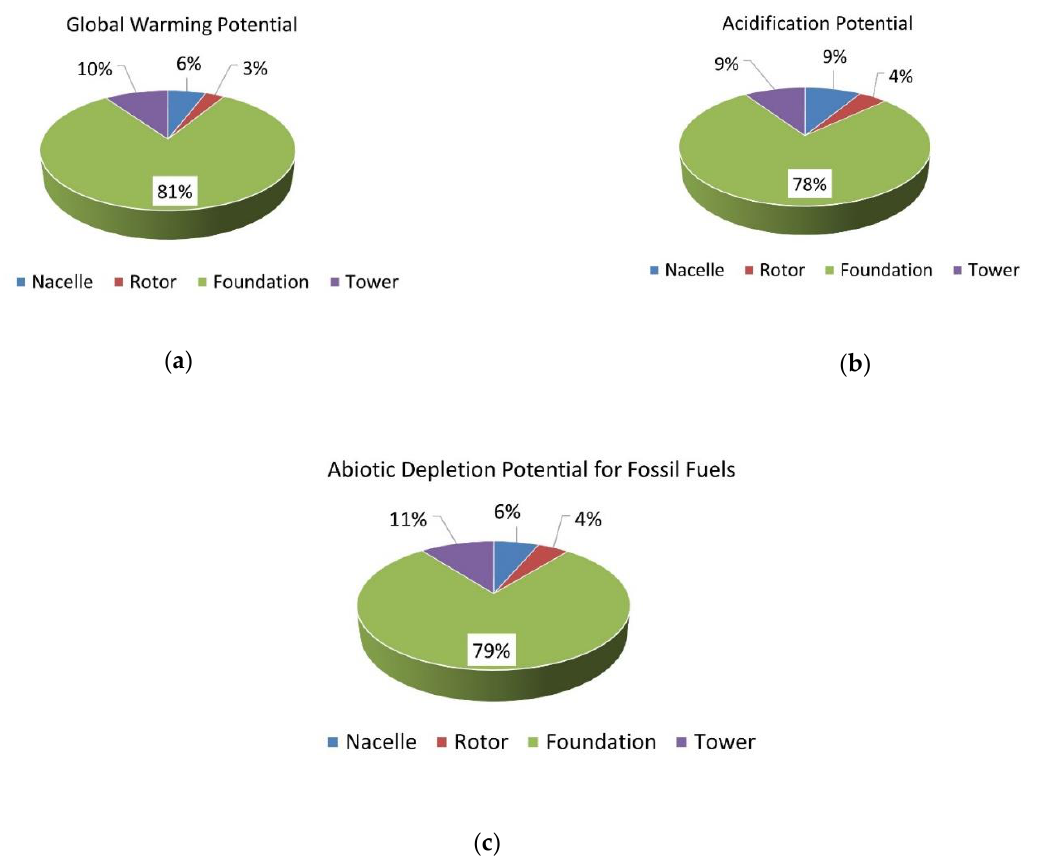
Figure 5. Contribution of the parts of the floating wind turbine to GWP ( a ), AP ( b ) and ADPF ( c ).